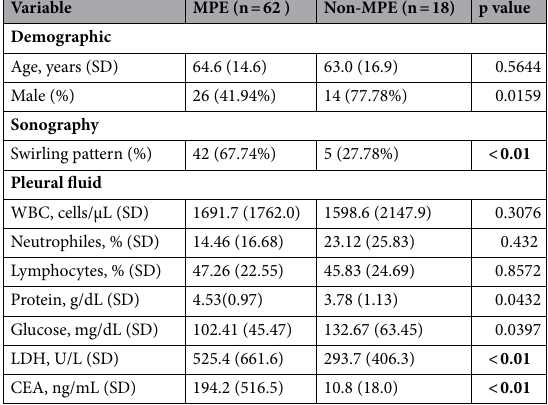
Table 2. Comparisons of demographic, sonographic and pleural fluid data between patient with MPE and those with non-MPE. Significant values are in bold.